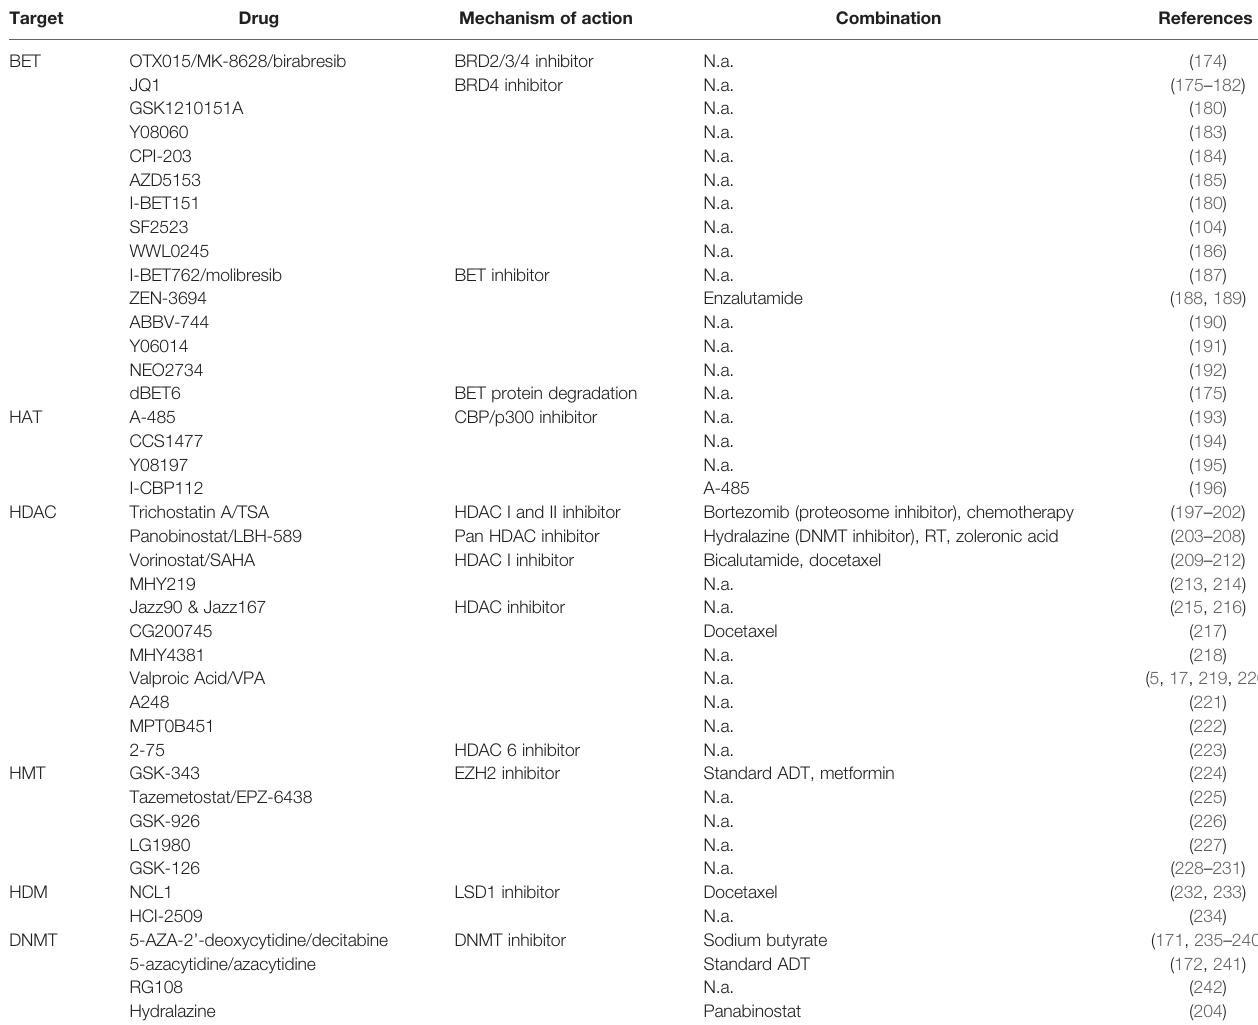
TABLE 2 | Potential epigenetic targets and epi-drugs for the management of therapy resistant prostate